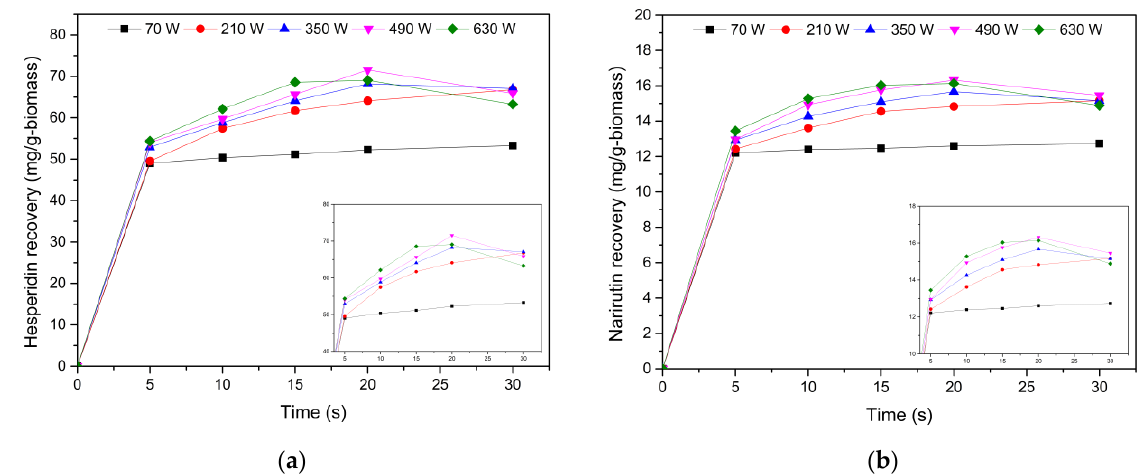
Figure 2. Effect of microwave power and irradiation time on the hesperidin ( a ) and narirutin ( b ) recovery from MPs.